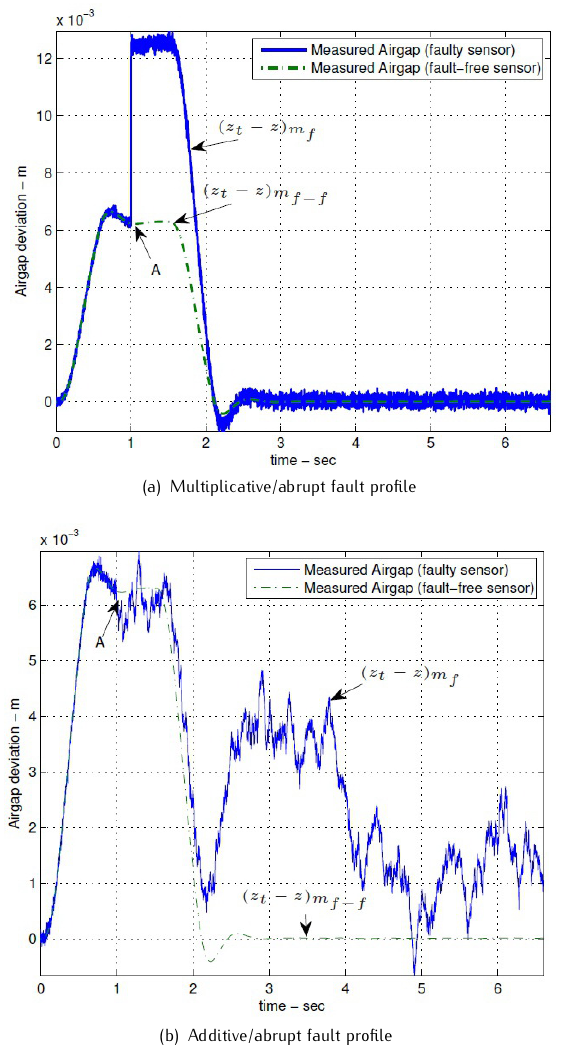
Figure 7. Airgapsensor(multiplicativeandadditive)abruptfaultpro- files for a deterministic input to the suspension